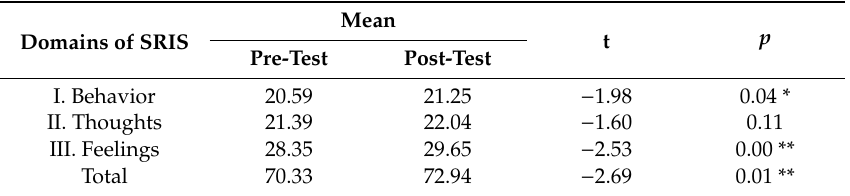
Table 1. Comparison of scores of SRIS before and after ELP ( n = 103).